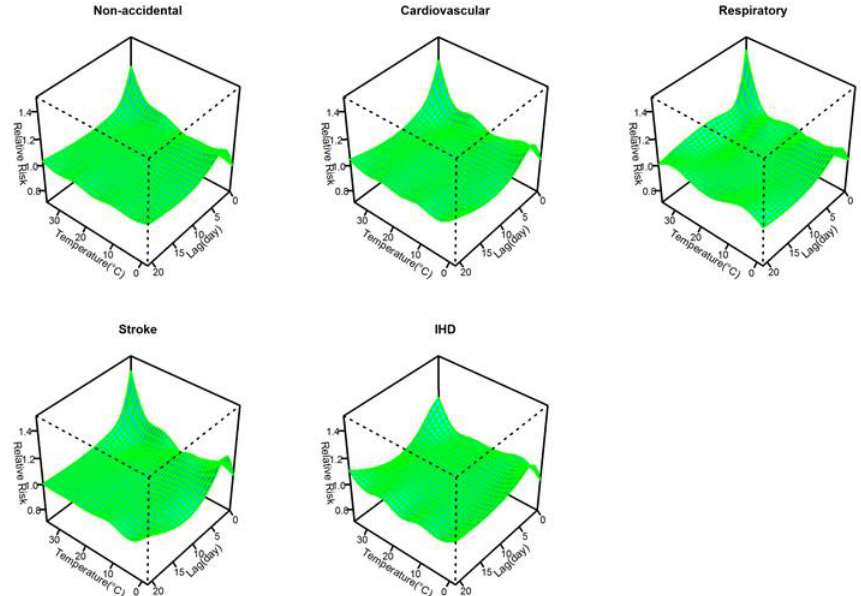
Figure 1. Relative risks of cause-specific mortality by mean temperature (°C) and lag in Jiang’an District of Wuhan, China during 2003 to 2010. The risks used 6 df for temperature and 4 df for lag up to 21 days and the reference temperature was the median temperature (19.2 °C) during the study period.